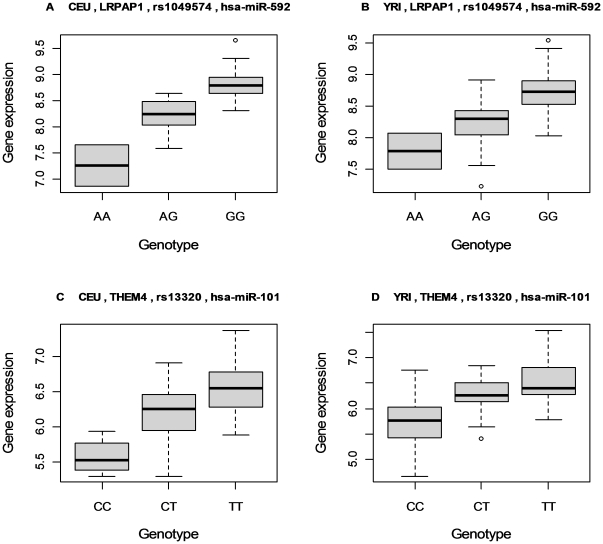
Box plots illustrating the additive pattern of miRNA target site effect (TSE) on gene expression.The upper plots A
 and
B
: Gene LRPAP1 has SNP rs1049574 in the 3′ UTR region. Based on the reference sequence hg18, the original nucleotide guanine (G) is not involved in any miRNA target site. The alternative nucleotide adenine (A) leads to the creation of a novel target site for miR-592. As a result, a sample of genotype GG, GA or AA has zero, one or two miRNA target sites due to this SNP, respectively. As shown in these two plots, the TSE in this created-target-site example well reflects an additive pattern for the post-transcriptional regulation of the target gene by the cognate miRNA in both populations. The lower plots C
 and
D
: gene THEM4 has SNP rs13320 in the 3′ UTR region. Based on the reference sequence hg18, the original nucleotide cytosine (C) is involved in a target site of miR-101. The alternative nucleotide thymine (T) leads to the disruption of the target site. As a result, a sample of genotype CC, CT or TT has two, one or zero miRNA target site due to this SNP, respectively. As shown in these two plots, the TSE in this disrupted-target-site example also well reflects an additive pattern for the post-transcriptional regulation of the target gene by the cognate miRNA in both populations.